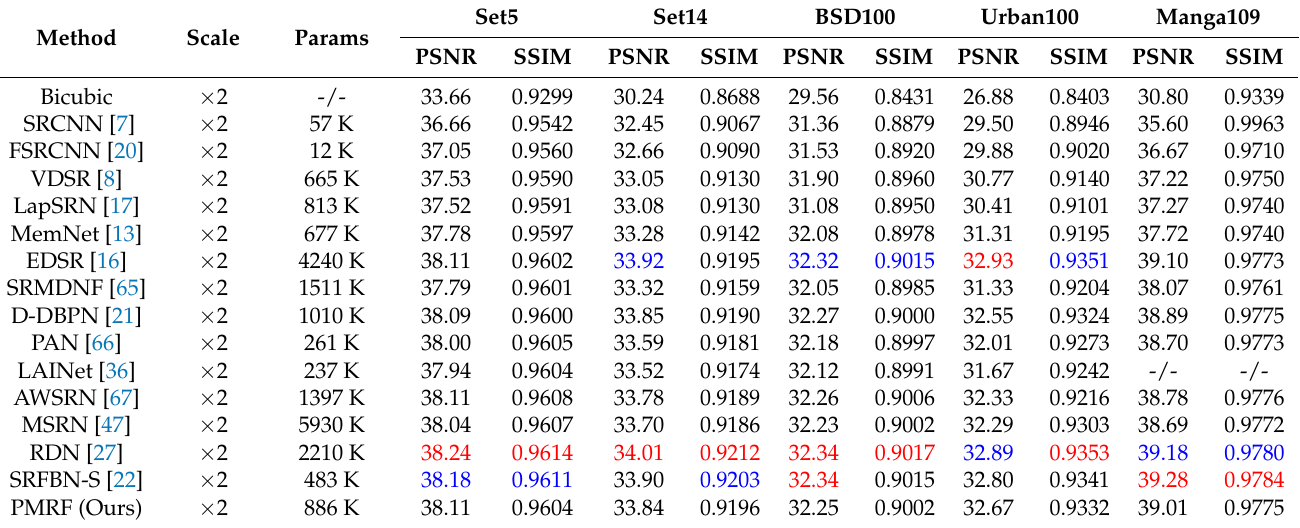
Table 8. Quantitative benchmark test results at × 2 scale. Red indicates the best performance and blue indicates the second best.